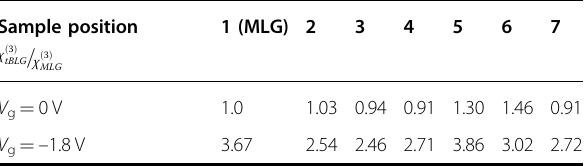
Table 1 Relative third-order susceptibility of tBLG compared with the THG intensity of neutral MLG at various sample positions at V g = 0 V (nongated) and – 1.8